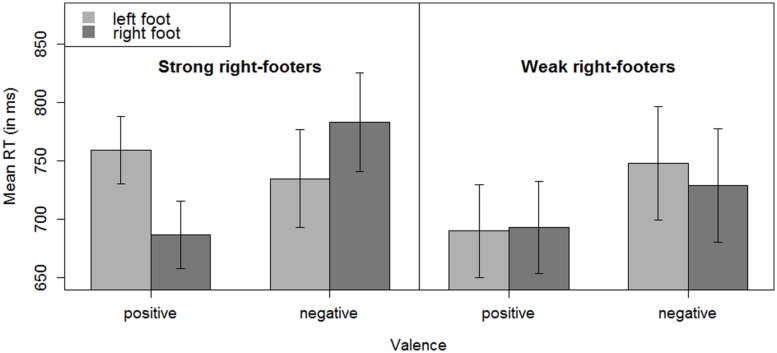
Mean response times for strong and weak right-footers. (Left) mean response times for strong right-footers (n = 21) for responses to positive and negative words with the right foot or with the left foot. (Right) mean response times for weak right-footers (n = 16) for responses to positive and negative words with the right foot or with the left foot. The error bars represent confidence intervals for within-subject designs and were computed as recommended by Masson and Loftus (2003).